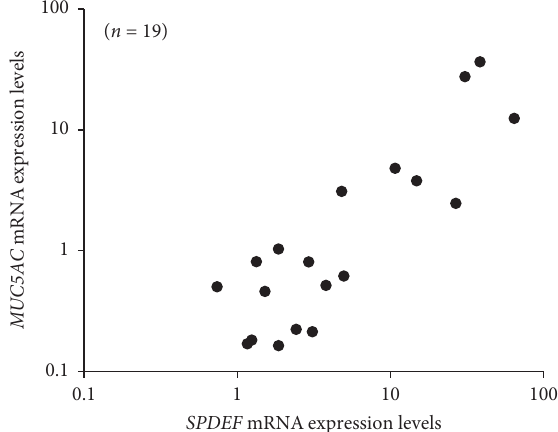
Figure 2: Correlation between SPDEF and MUC5AC mRNA ex- pression levels. To examine the correlation, data from the active and stable groups were merged. Spearman’s correlation coefficients showed significant correlations between SPDEF and MUC5AC mRNA expression levels ( ρ � 0.770, p � 0 .